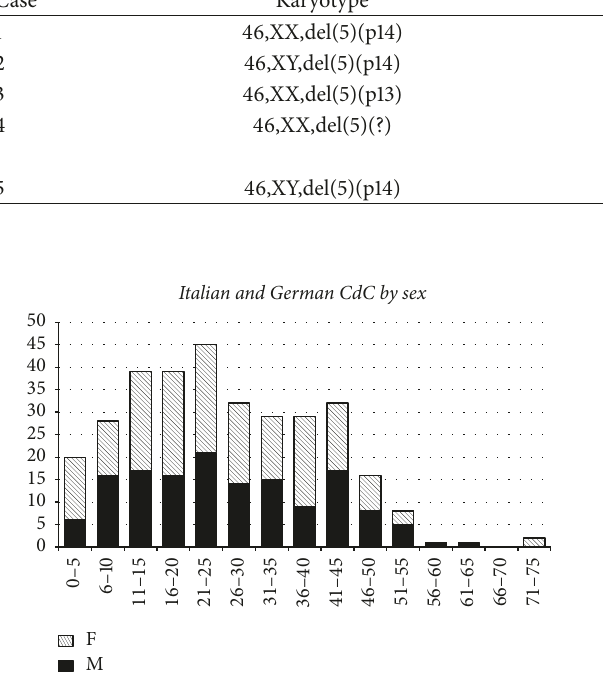
Figure 1: Distribution of 321 Italian and German CdC patients by age (abscissa, five years interval) and sex. F: females and M: males.